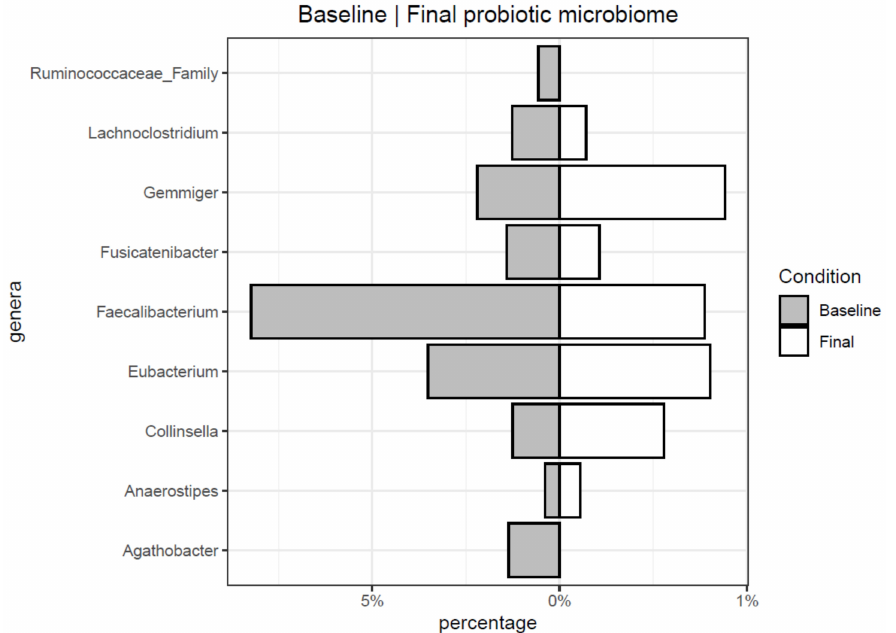
Figure 2. Significant genera before and after probiotic treatment.